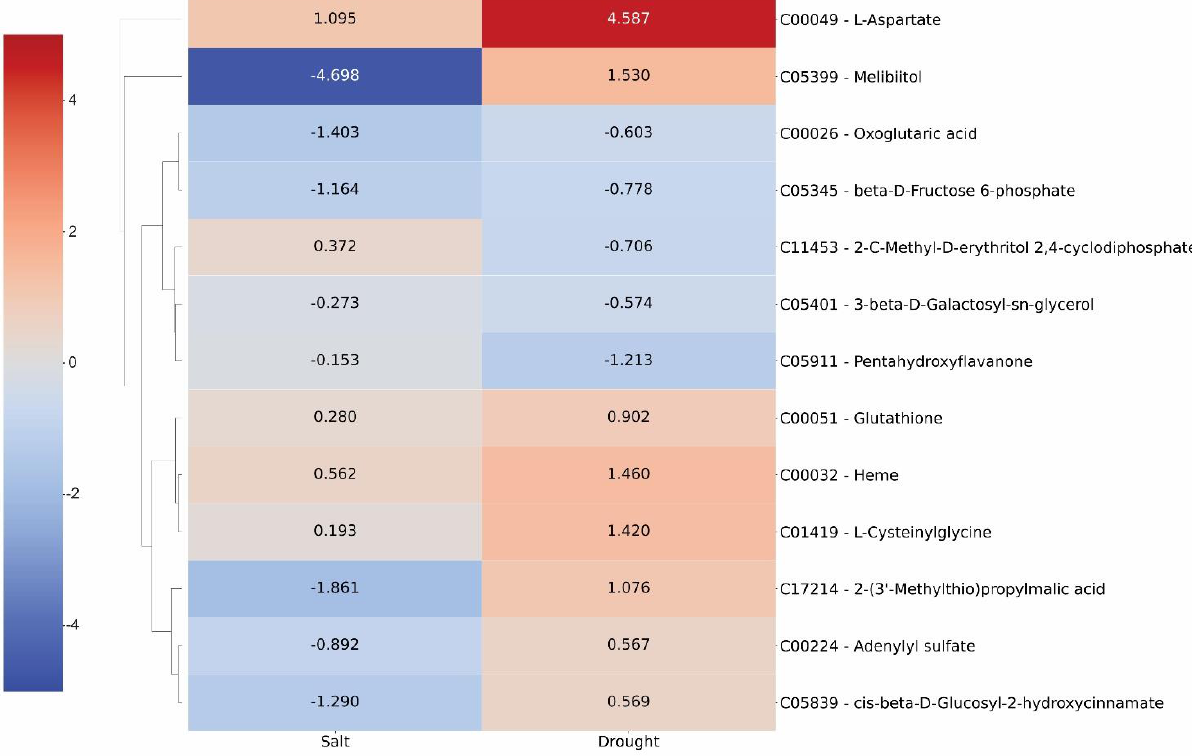
Figure 7. Heatmap of the 13 differentially expressed metabolites that were found in the two scenarios studied — drought and salinity stresses. Table 4. Molecules (full-length transcripts, metabolites, and proteins) from the Cysteine and methionine metabolism (map00270) pathway differentially expressed in the apical leaf of young oil palm plants under both drought and salinity stresses.